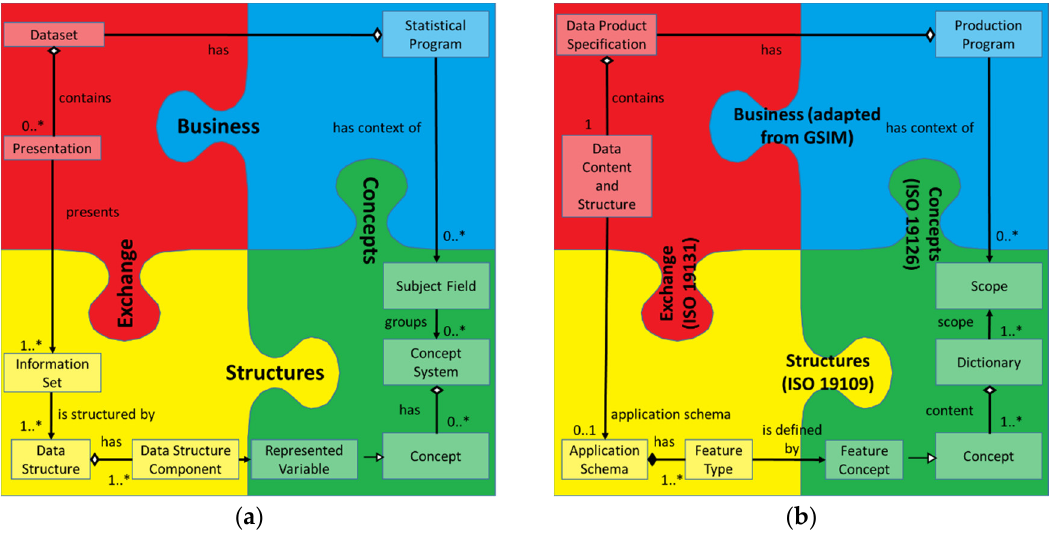
Figure 2. ( a ) The GSIM core. ( b ) The GeoIM core regarding ISO/TC211 standards.